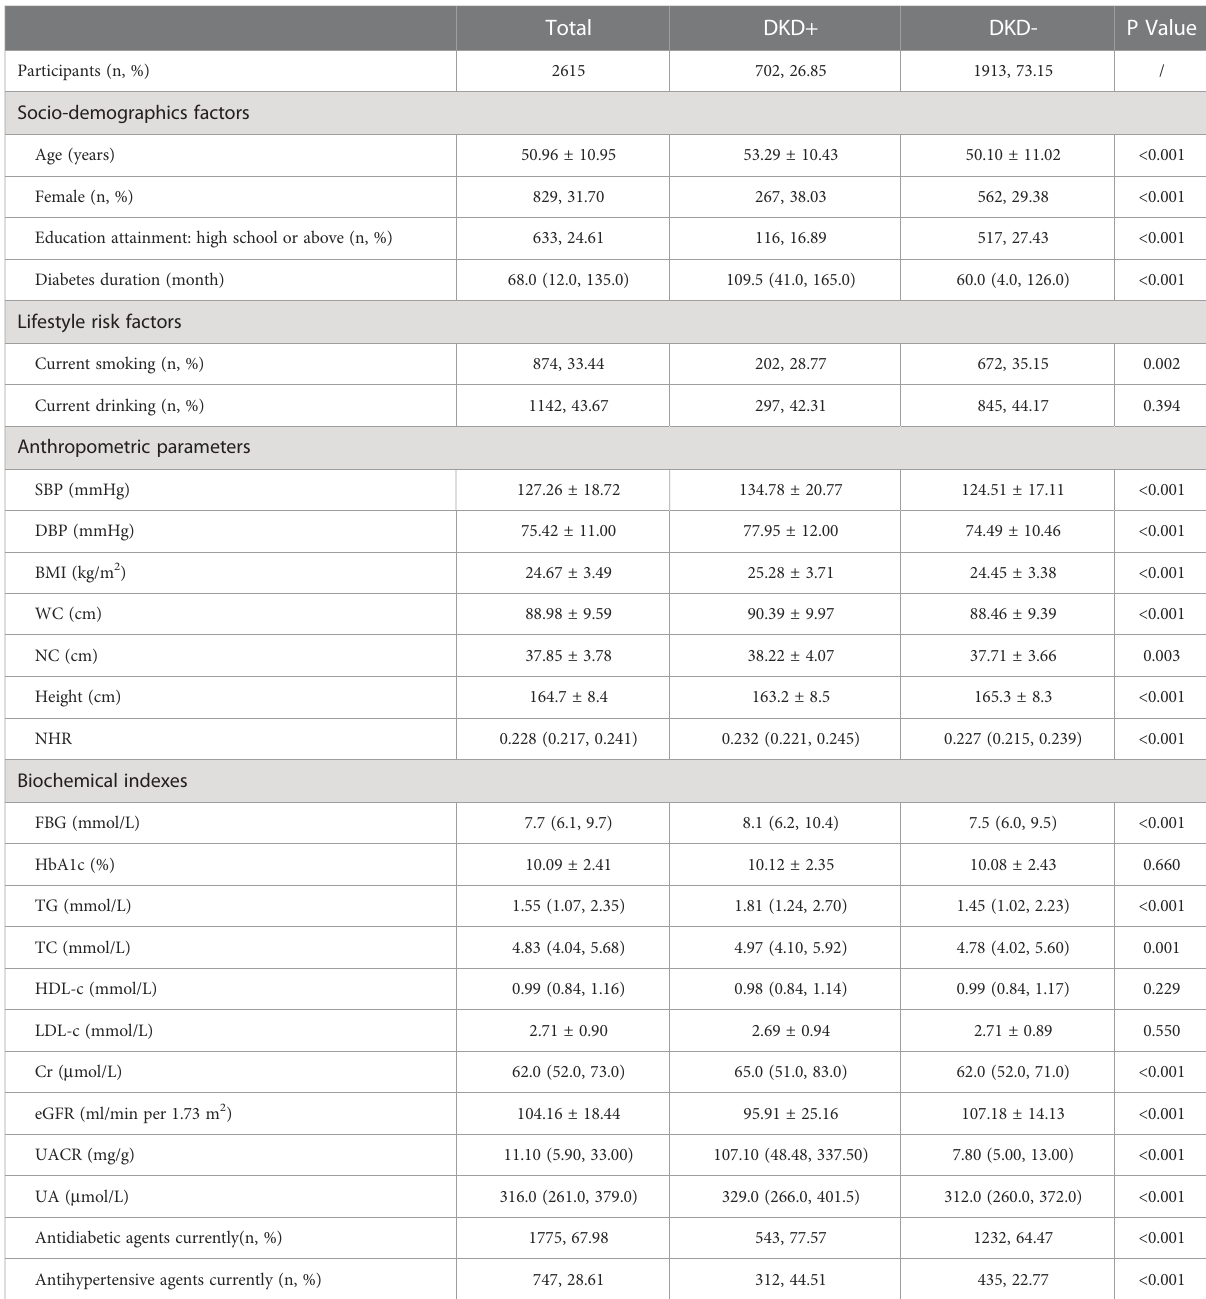
TABLE 1 Baseline characteristics of study participants based on DKD